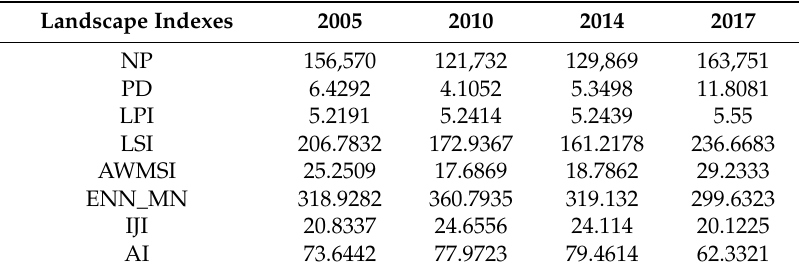
Table 6. Landscape index calculation results table. Landscape Indexes 2005